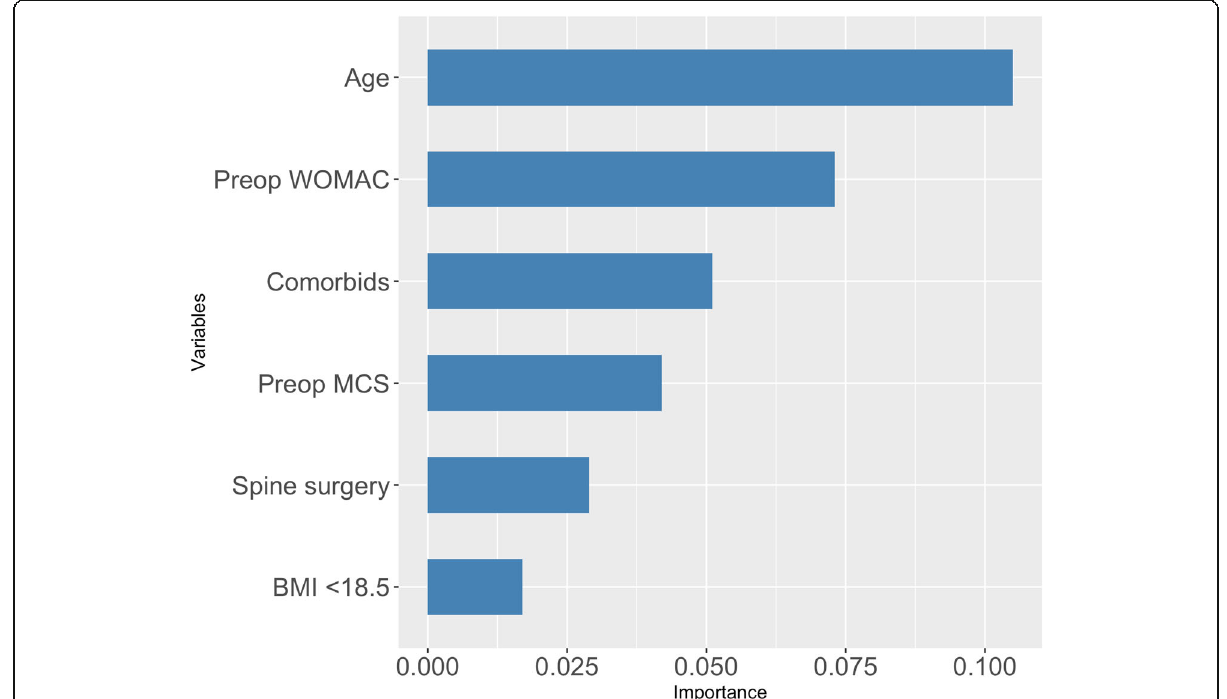
Fig. 3 Most important predictors of patient satisfaction: (1) patient ’ s age, (2) preoperative WOMAC, (3) number of comorbidities, (4) preoperative MCS, (5) previous lumbar spine surgery and (6) low BMI (<